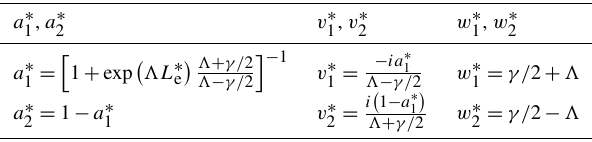
Table A1. Analytical expressions for unknown complex variables for the case of a closed